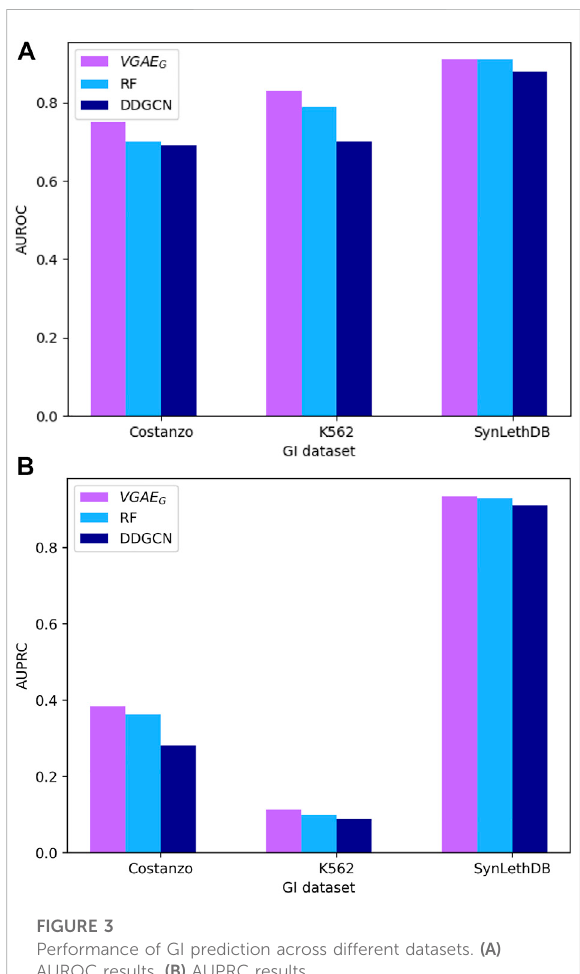
FIGURE 3 Performance of GI prediction across different datasets. (A) AUROC results. (B) AUPRC